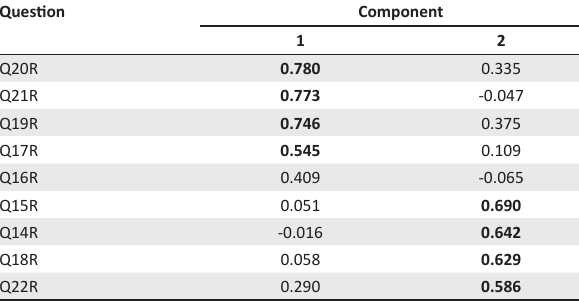
FIGURE 1: Scree plot for financial literacy. TABLE 9: Rotated component matrix † for financial